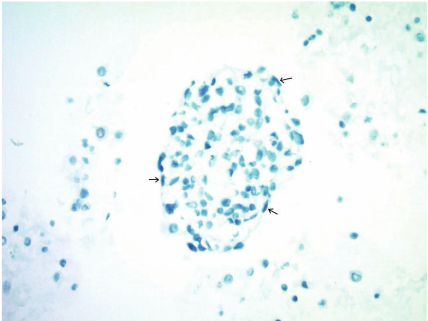
Figure 7: A cohesive group of metastatic DSRCT cells in pleural fluid with central epithelioid forms and a few flattened/elongated cell forms at the periphery of the island, marked with small arrows. The lesional central epithelioid cells are diffusely immunoreactive with cytokeratin AE1/AE3, and the peripheral spindled forms show the same pattern of reactivity with strong cytoplasmic staining (cell block, AE1/AE3 immunohistochemistry, 400x).